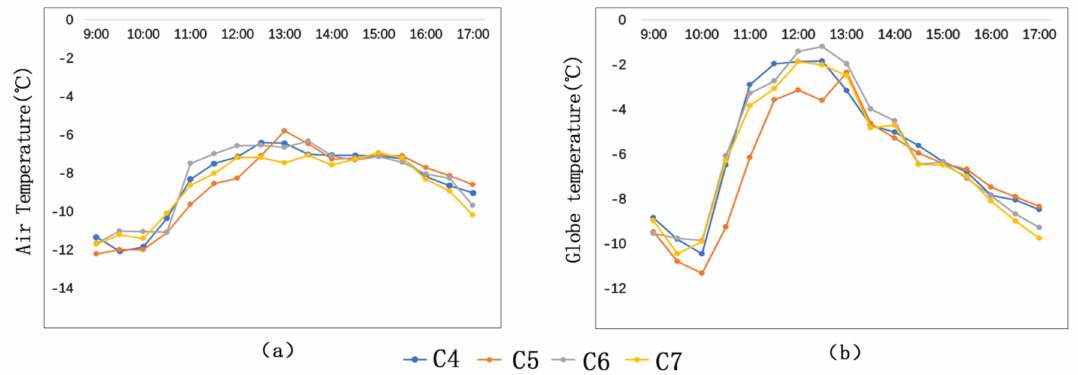
Figure 9. Air temperature comparison and globe temperature comparison at the semi-open-type streets: ( a ) Ta; ( b ) Tg.